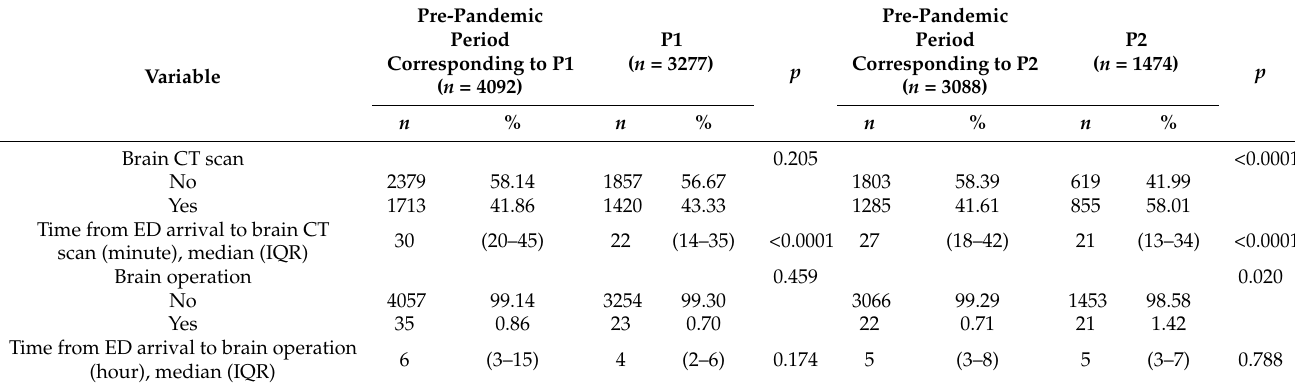
Table 3. Comparison of treatment efficiencies for TBI-related ED visits before and after the COVID-19